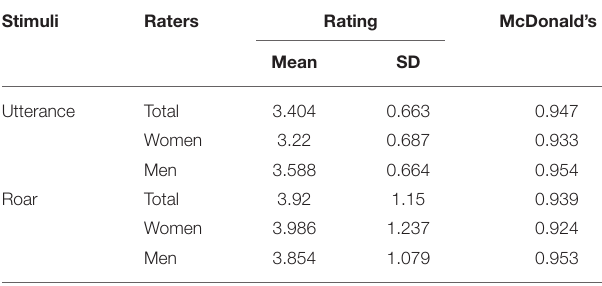
TABLE 2 | Formidability rating descriptive statistics.